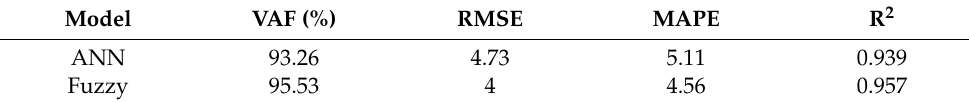
Table 4. Statistical comparison between the values of ANN and Fuzzy model [72].